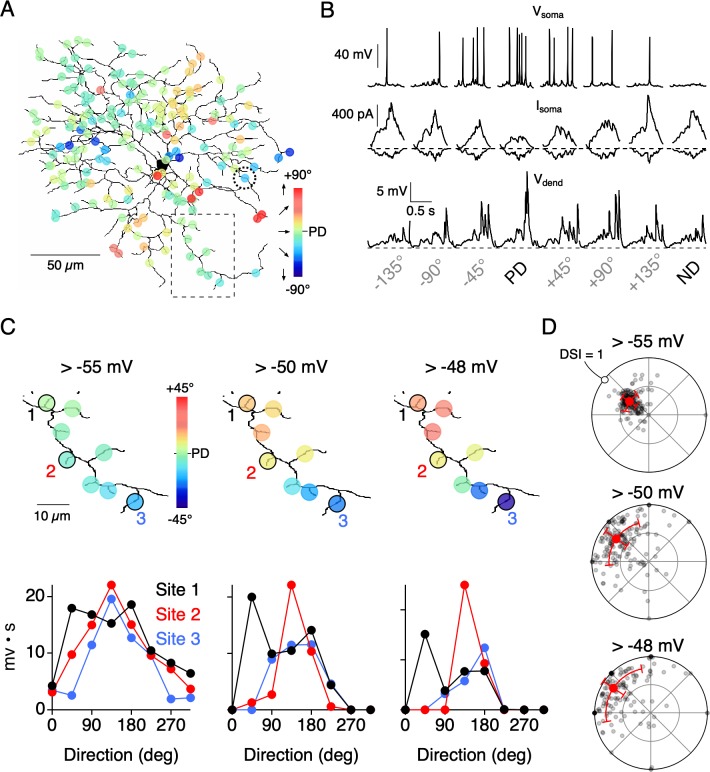
Threshold nonlinearities encourage dendritic compartmentalization.(A) Reconstruction of an ON-OFF DSGC used in a multicompartmental in NEURON (Poleg-Polsky and Diamond, 2016; see Materials and methods for details). Simulated responses to motion in eight directions gave rise to directional tuning at 177 dendritic sites. These responses were measured in the absence of NaV activity. (B) Top, Somatic voltage (Vsoma) measured with NaV activity intact in response to 8 directions of motion. Middle and Bottom, somatic excitatory and inhibitory currents (Isoma), and voltage measured from a single dendritic site (Vdend; from site circled in A) in the absence of NaV activity. The PD of the integrated voltage responses (above a threshold of −55 mV) was used to compute the PDs shown in A. (C) Expanded view of the dendritic branch indicated by the boxed area in A, showing how the stringency of the voltage threshold (indicated above images) can affect the directional tuning in nearby dendritic sites. The integrated voltage at three sites is shown below. (D) Polar plots showing the distribution of PDs and DSIs measured over the dendritic tree, measured using different threshold values. Note, in the model all sites have the same average tuning, and the differences in tuning between sites only occur on single trial sets (eight directions) due to the stochastic nature of transmitter release.Figure 7—source data 1.Dendritic voltage responses and directional tuning measurements.